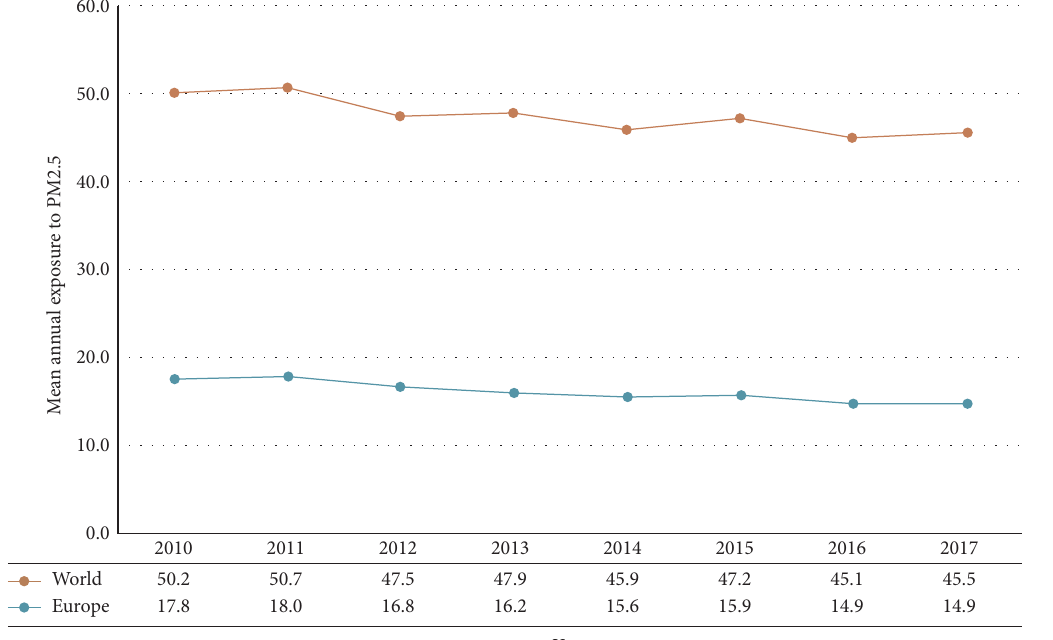
2.5 in the world and Europe.